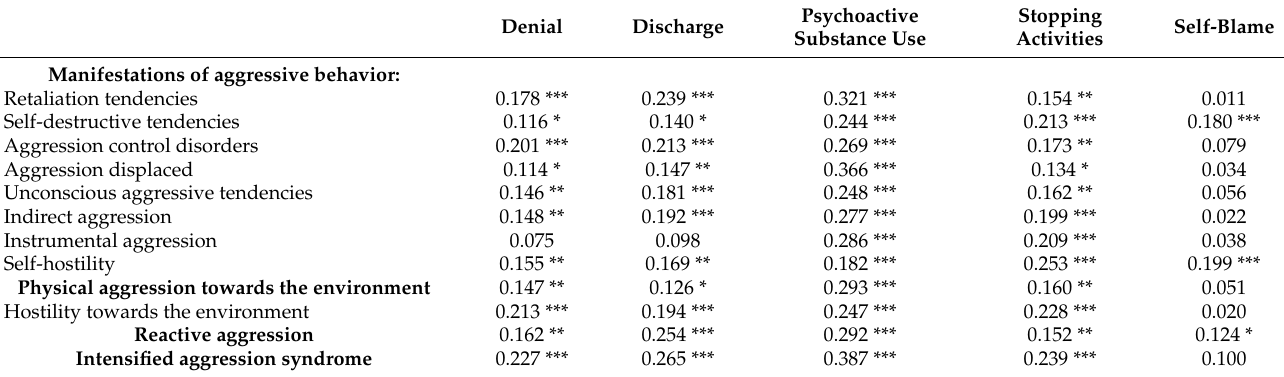
Table 6. Correlations (Pearson’s r ) between passive strategies of coping with stress (measurement: MINI-COPE—two avoidance strategies, three emotional strategies) and the manifestation of aggressive behavior (measurement: IPSA II—a general intensity in the aggression syndrome and its 11 dimensions) among seniors ( n =